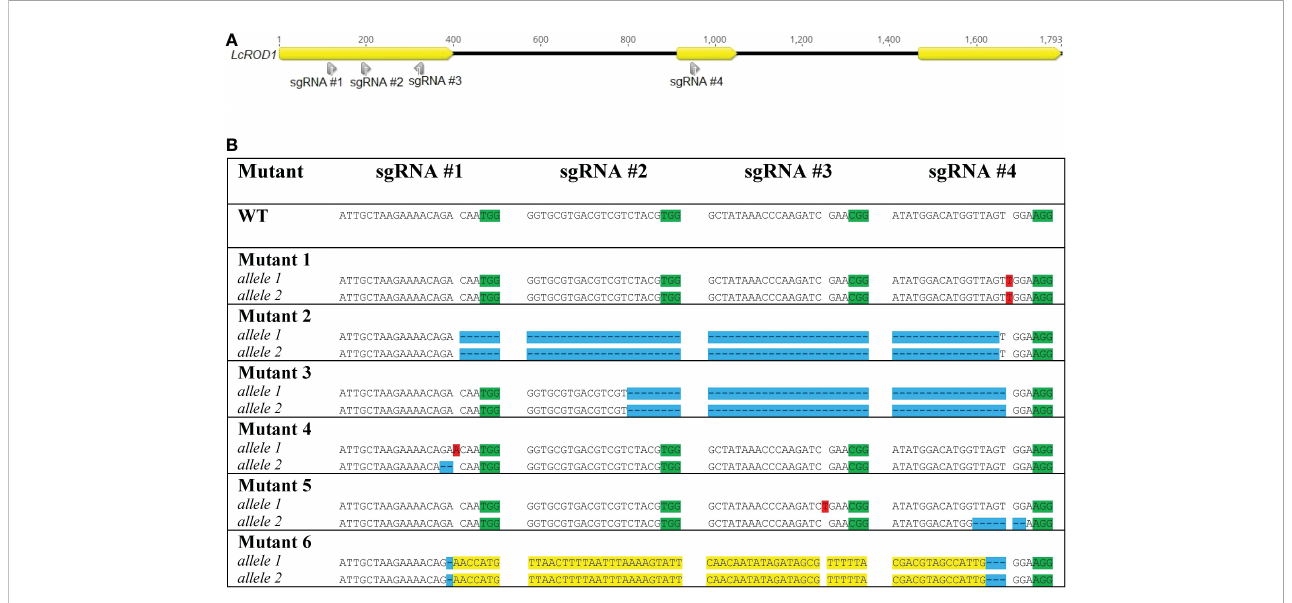
FIGURE 2 Locations of sgRNAs selected (A) and types of mutations detected in ROD1 in different mutant lines (B) . Insertions are highlighted in red. Deletions are highlighted in blue. Inversions are highlighted in yellow. PAM sites are highlighted in